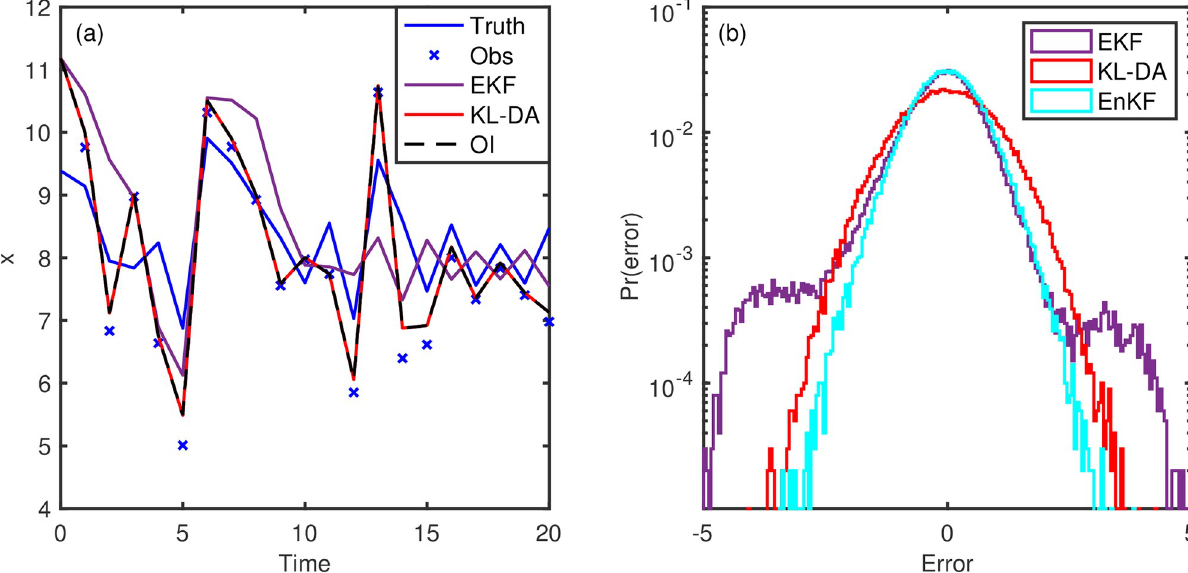
Fig 4. Experiment 2 results. The modelled data assimilation solutions (a) and the log-scale histogram of the errors (b).